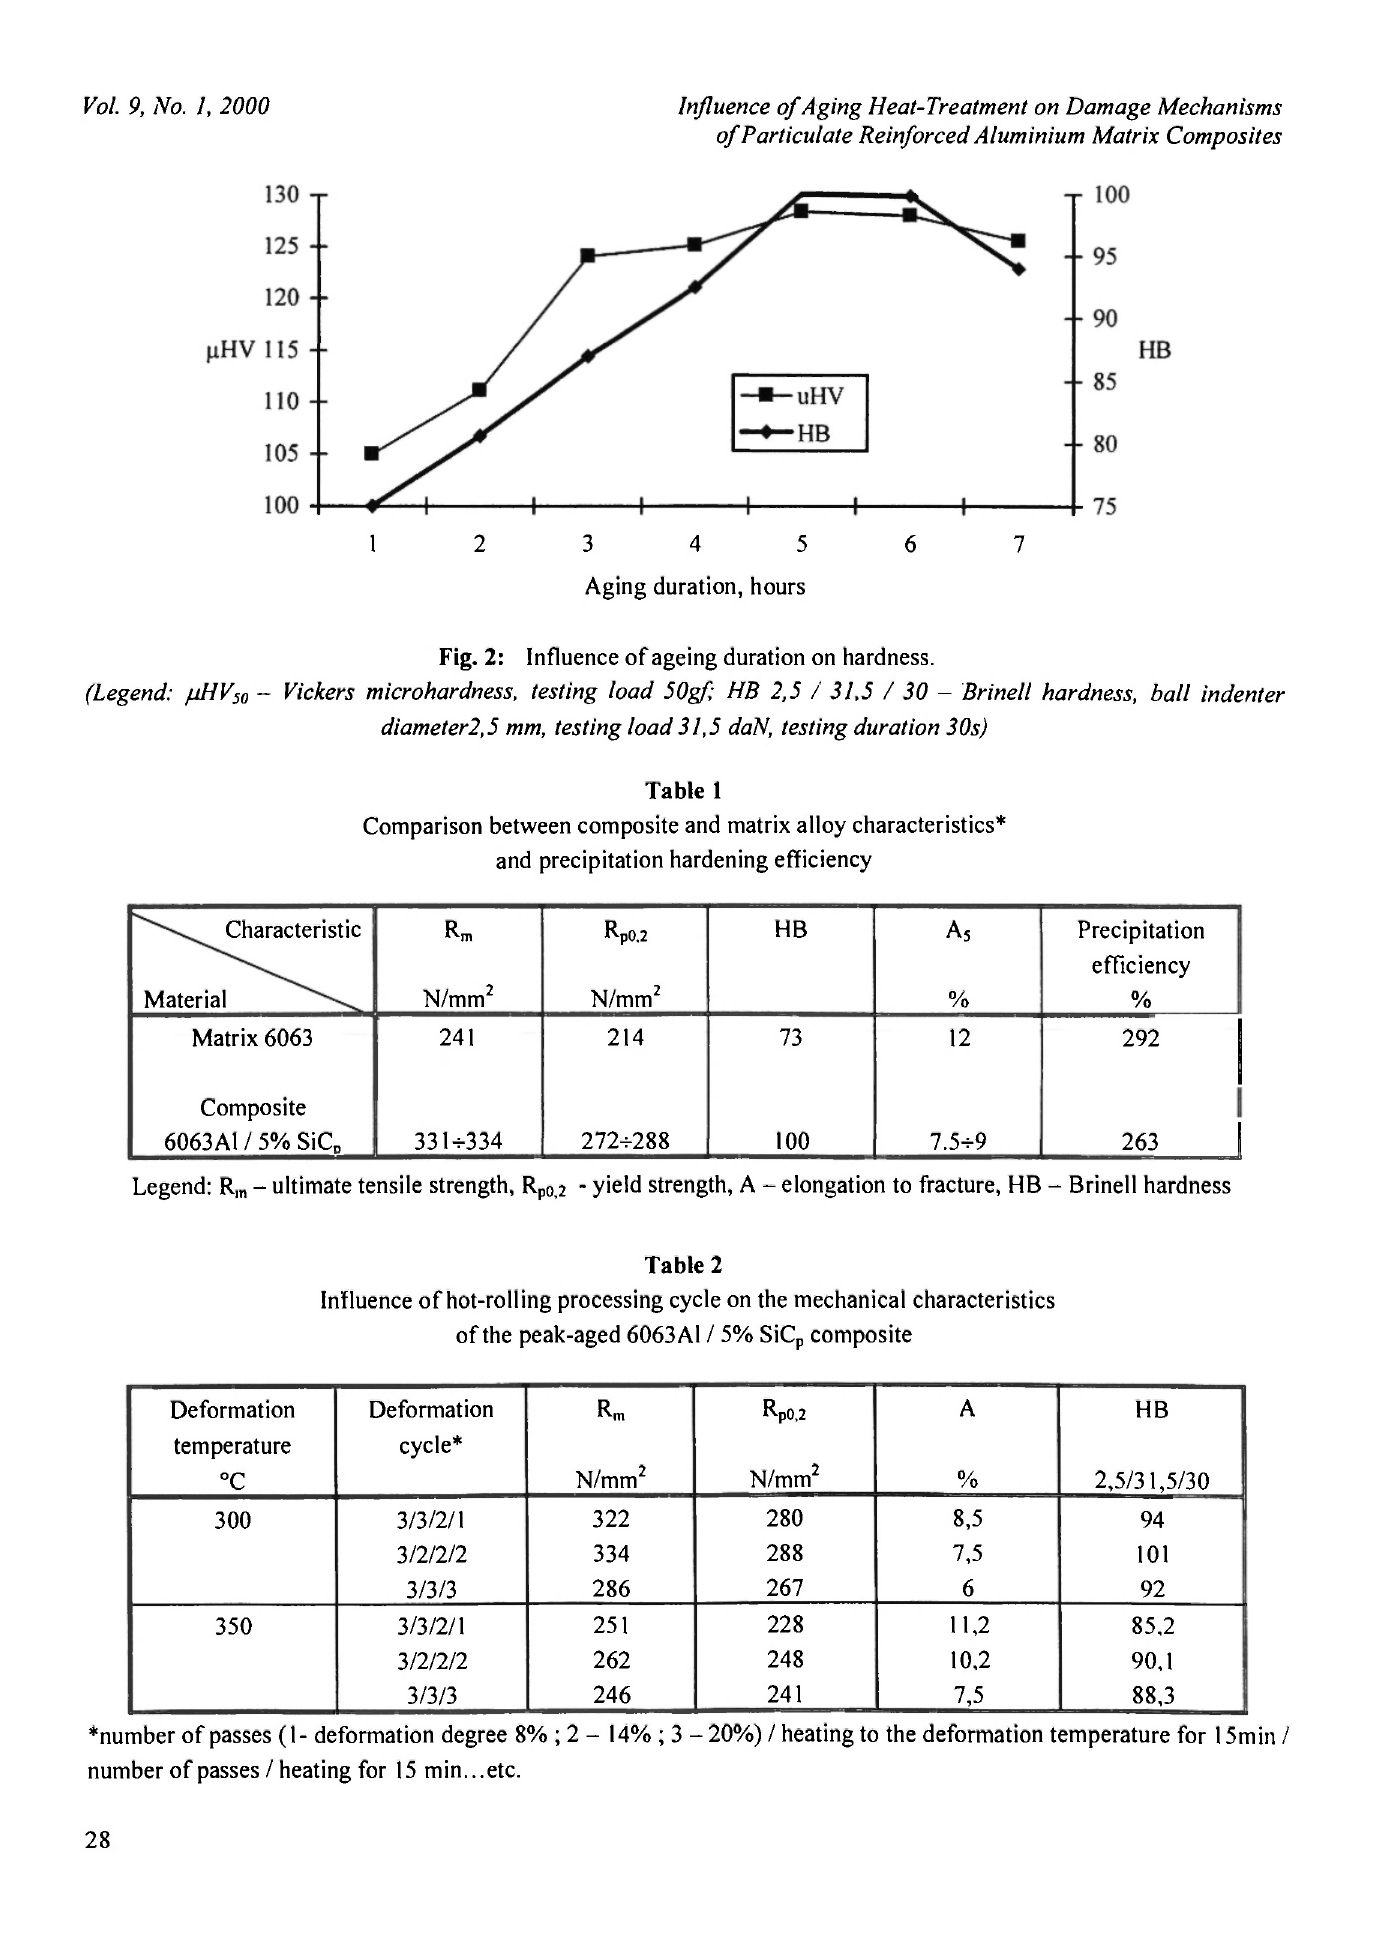
Fig. 2: Influence of ageing duration on hardness.